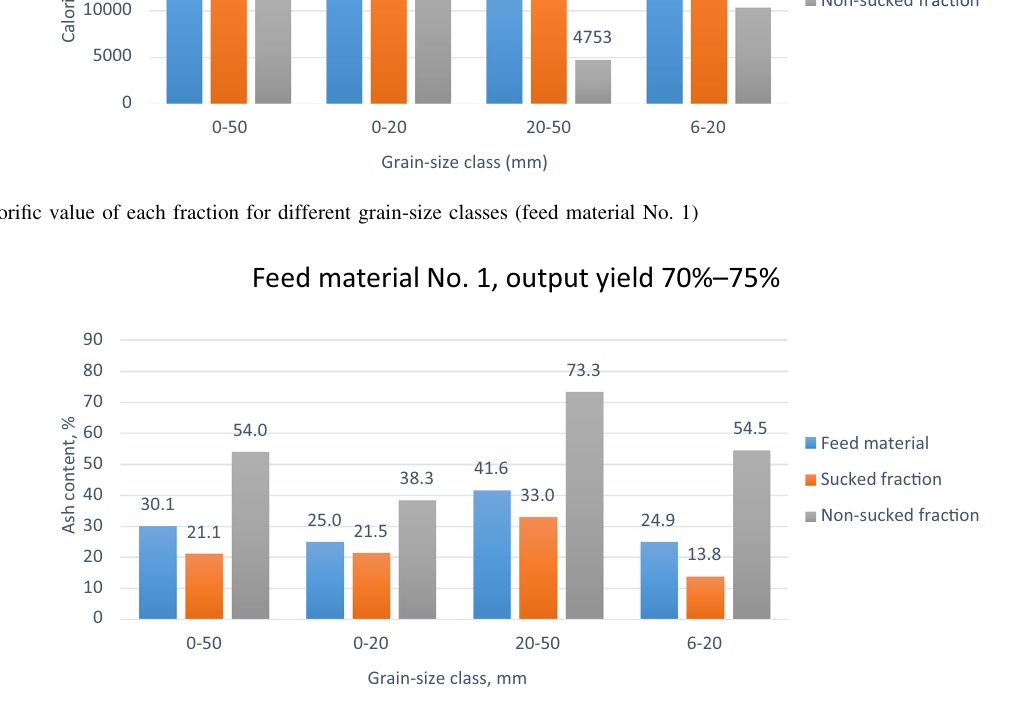
Fig. 10 Ash content in each fraction for different grain-size classes (feed material No.